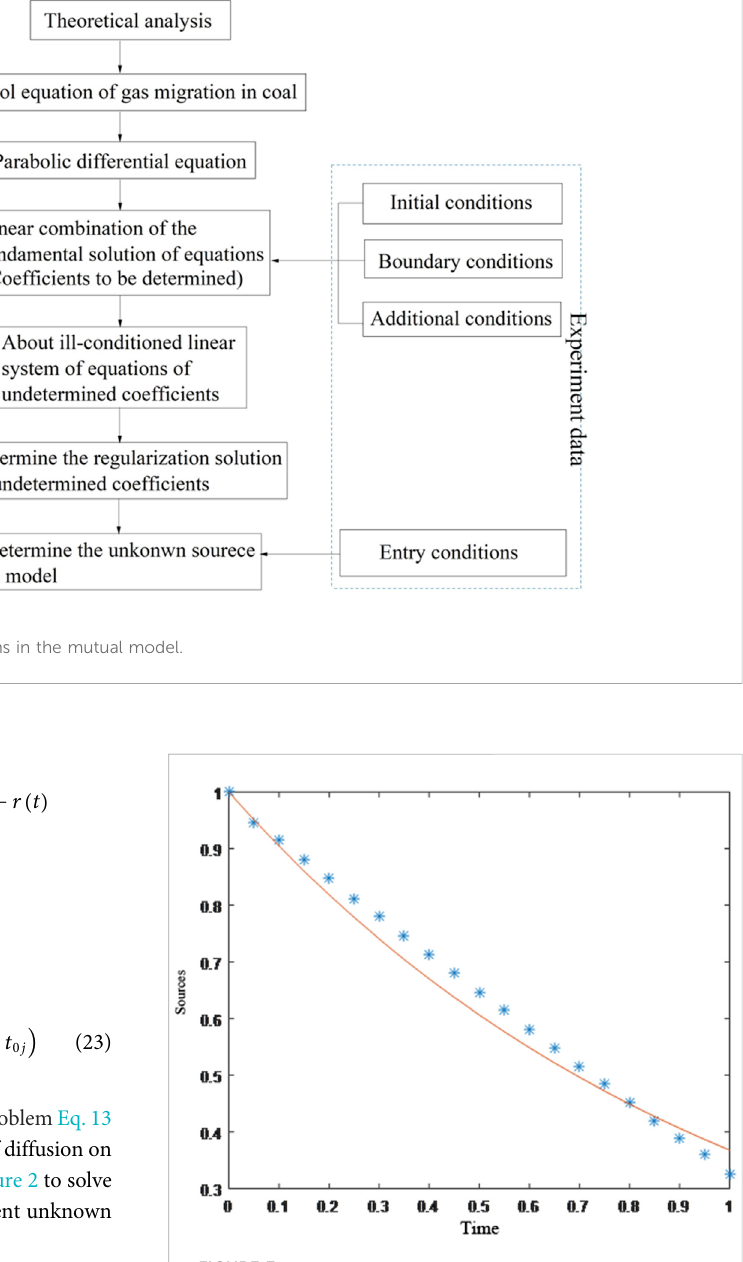
FIGURE 3 Comparison of the theoretical and computed sources. Note: “ * ” indicatesthesourcevaluedeterminedaccordingtothemethod in this paper, and “ - ” indicates the theoretical value of the